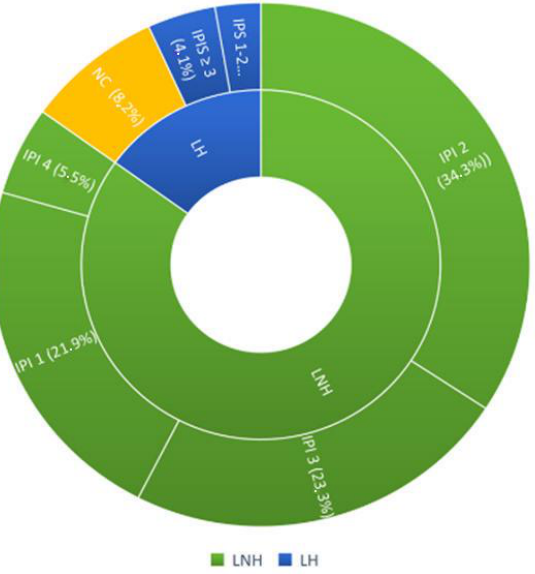
Figure 2. Representation of the prognostic stratification of the patients included in the study.